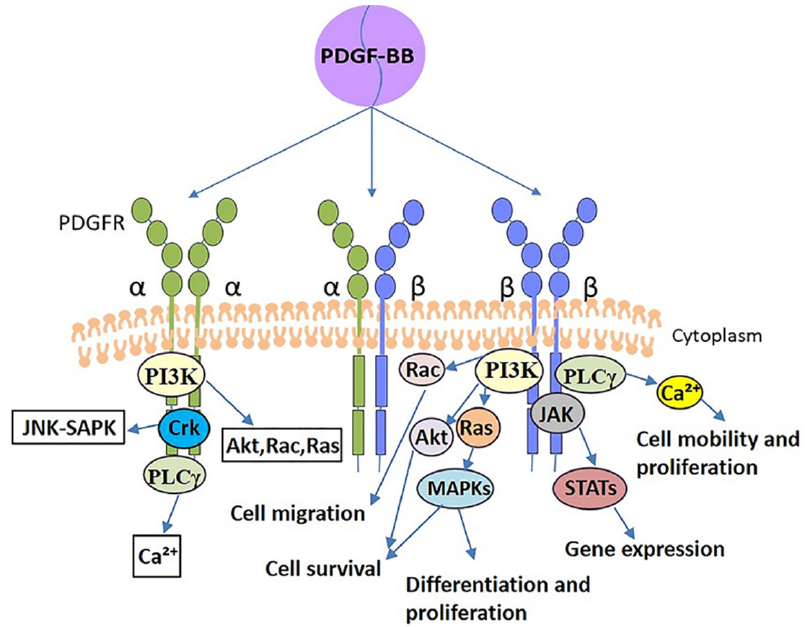
Figure 2. A simplified representation of the signaling action after PDGF-BB binding to PDGFR β , which is mainly involved in tendon cell-related activities, has been made, and other mechanistic processes have been omitted. Green circles and blue circles are receptors for PDGF; α , α receptor of PDGF; β , β receptor of PDGF.